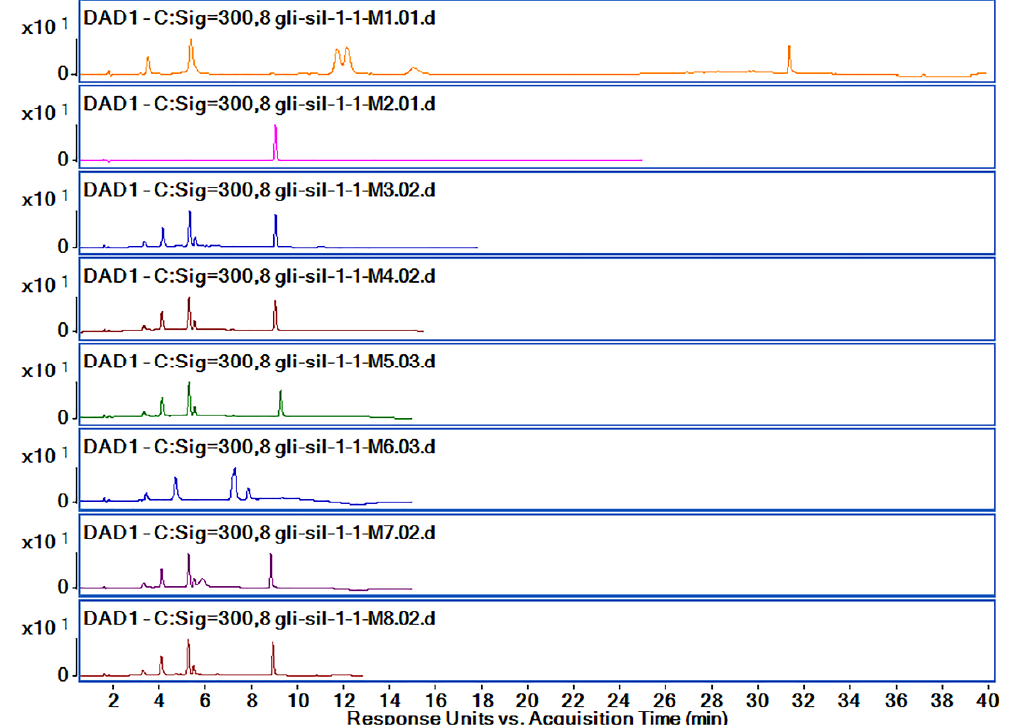
Figure 5. Chromatograms obtained by HPLC-DAD (300 nm) for the active substances’ mixtures using M 1 ; retention times: Sil A 11.55 min, Sil B 12.32 min and Gli 31.9 min.